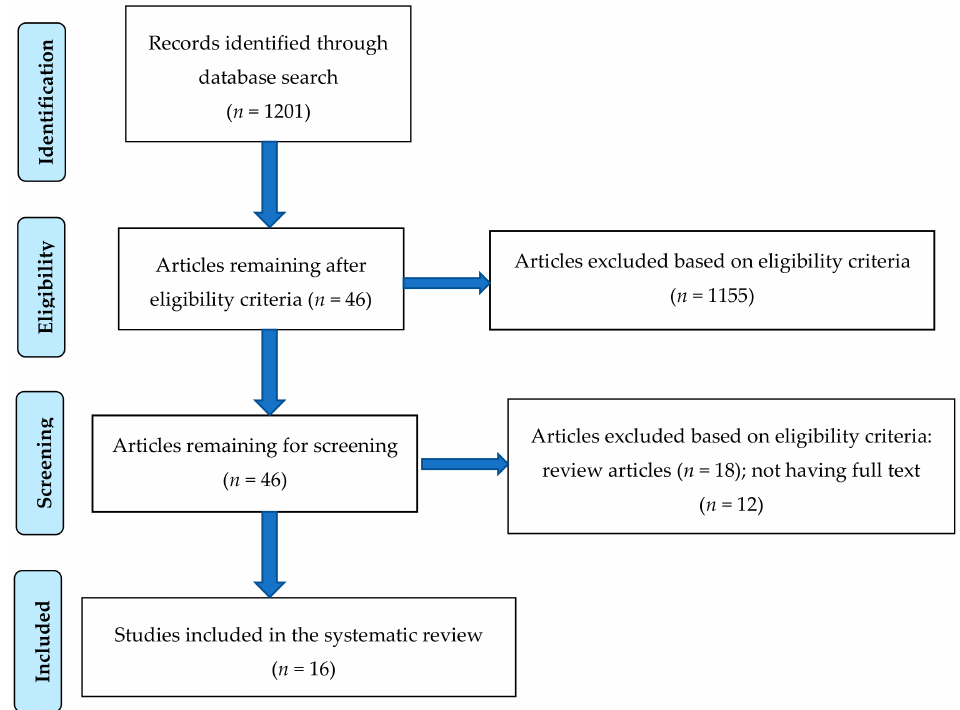
Figure 1. PRISMA flow chart to illustrate the article search and the inclusion